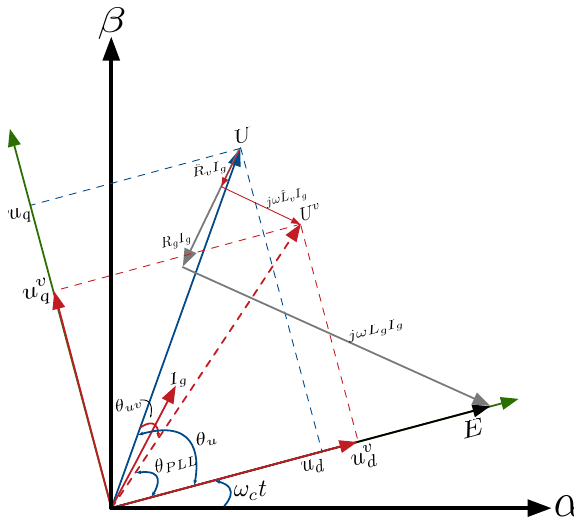
Figure 6. Vector diagram of the